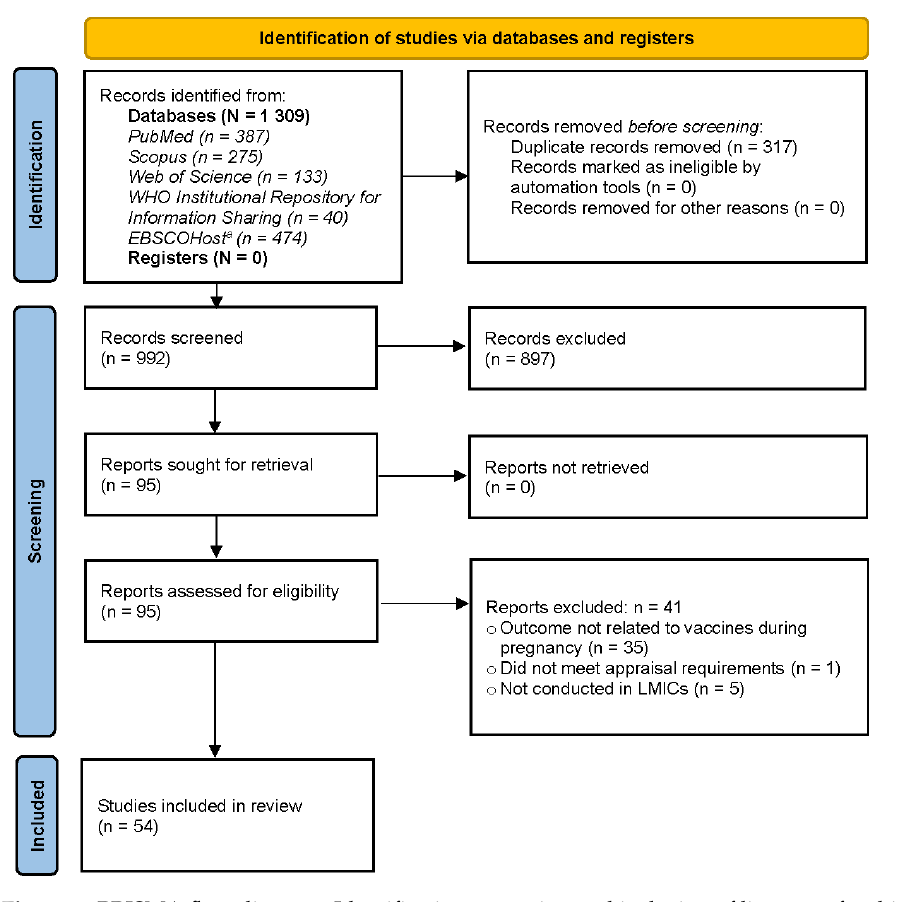
Figure 1. PRISMA flow diagram. Identification, screening and inclusion of literature for this qualitative systematic review [24]. a Databases searched within EBSCOHost included Academic Premier, Africa Wide information, CINAHL, Health Source Nursing Academic, Medline, APA Psych, and APA